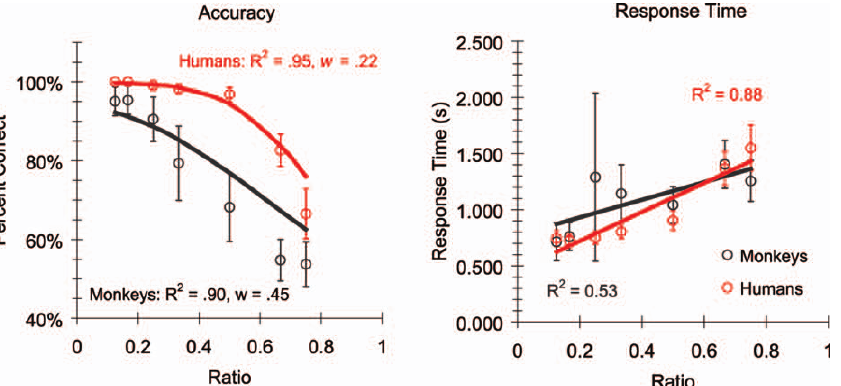
Figure 5. Monkeys Perform Addition like Humans Monkeys and humans exhibited ratio-dependent accuracy and response time when solving addition problems. For accuracy (left panel), solid lines show the predicted data from Equation 1 for humans (red) and monkeys (gray) at the best fitting w . The R 2 values for accuracy show the strength of the fit. Response times (right panel) are fit with a linear function, and the corresponding R 2 values are reported. Error bars reflect the standard error among subjects.